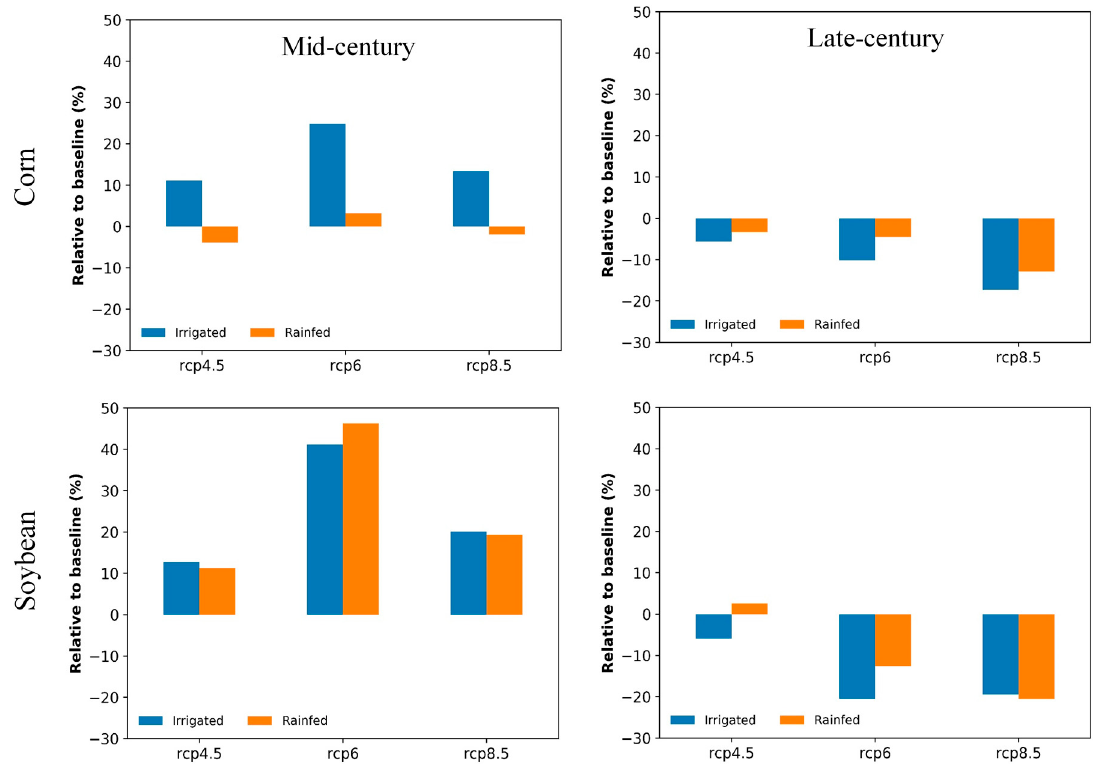
Figure 9. Relative change in crop yield for corn and soybean under three RCPs for mid-century (2035– 2049) and late-century (2085–2099) compared to baseline period